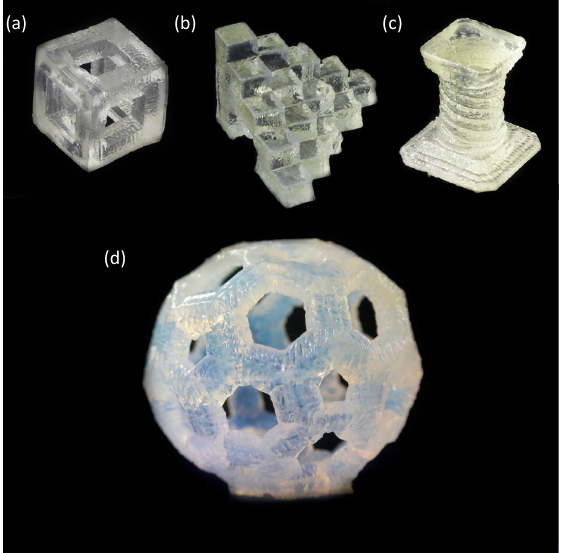
Figure 2. 3D printed SMG structures ( a ) Koji cube (20 mm 3 outer dimensions with a 10 mm 3 hollow inside) ( b ) 5 mm calibration cube step ( c ) spiral pillar (34 mm height, bottom stage 30 mm 2 and upper stage 21 mm 2 ) ( d ) Buckyball (outer diameter 34.5 mm); Material: